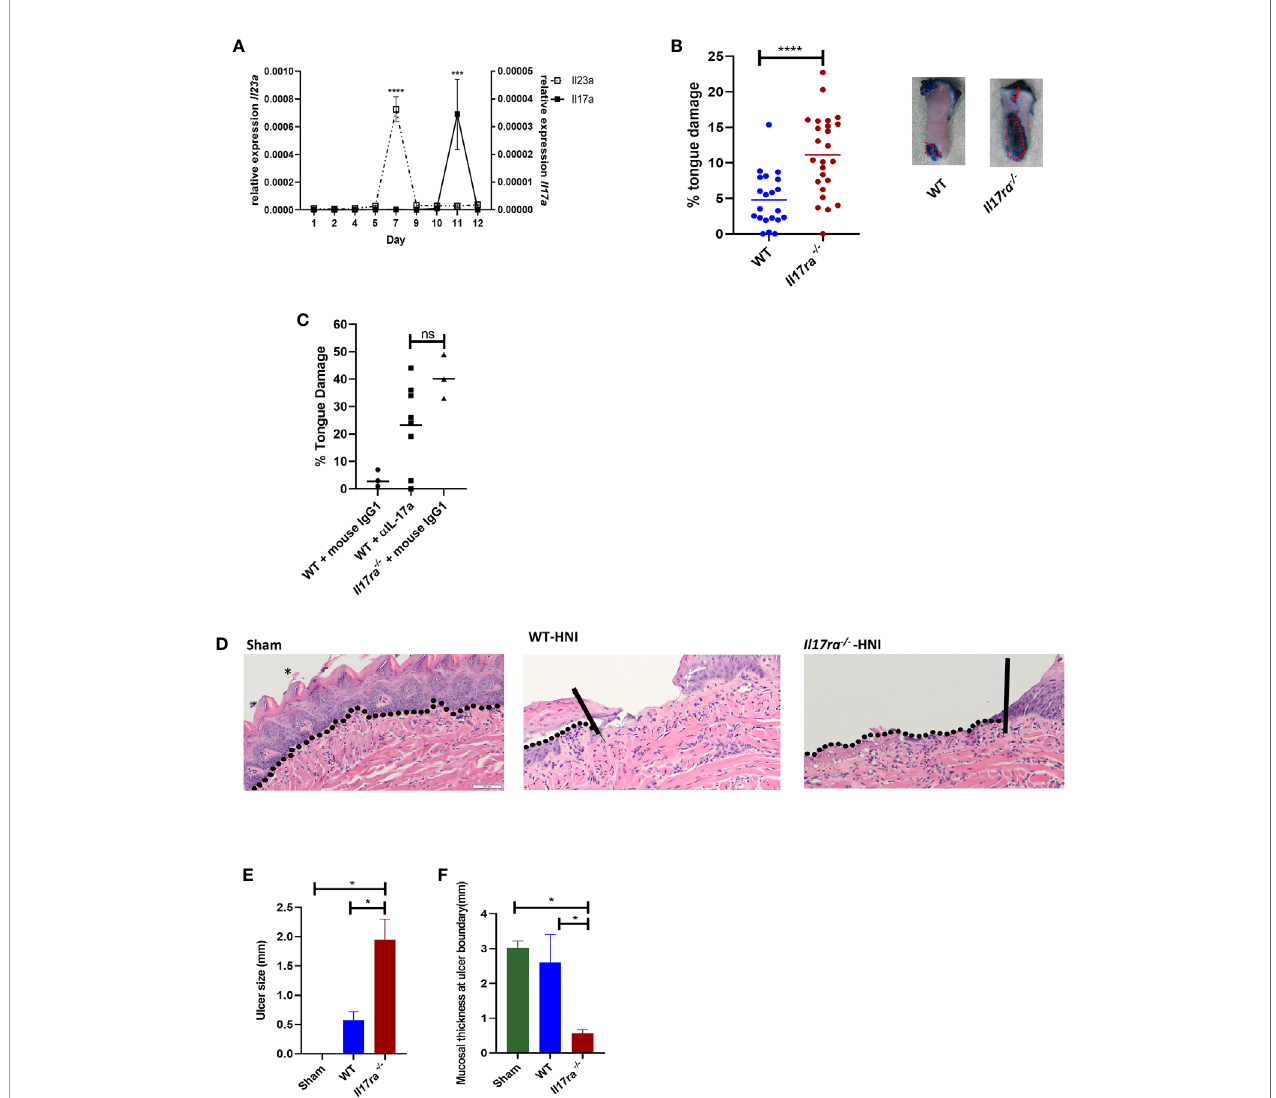
FIGURE 2 | IL-17 is induced and is protective following HNI (A) Expression kinetics of Il23 and Il17a following HNI assessed by qPCR. Results pooled from at least three experiments analyzed by ANOVA with Tukey ’ s post hoc . (B) Quanti fi cation of toluidine blue staining by determining the surface area of the tongue positive for blue staining compared to the total surface area of tongue on each mouse on day 11 post radiation. The staining on the ventral side of the tongue was not included in the quanti fi cation since this included the excision site. Red dotted lines represent the surface area of a lesion as determined for all tongues. Data pooled from at least three experiments. Analyzed by Student ’ s t test. (C) Mice were treated on days 8 and 10 with a -IL-17A or mouse IgG1 (150 µg) and damage quanti fi ed on day 11 (n = at least three per group). Control animals received appropriate isotype controls ( Supplementary Table 2 ). Tongue damage analyzed by ANOVA with Tukey ’ s. (D) Hematoxylin – eosin staining of mouse tongues D11 following radiation. Asterisk denotes papillae. The vertical lines in the images of tongues highlight the ulcer boundary and the dotted lines represent the epithelial-stromal boundary. (E, F) Quanti fi cation of lingual ulcer size and mucosal thickness (N= at least 5 per group). Data represents as least three pooled experiments. Analyzed by ANOVA with Tukey ’ s post hoc . Scale bars: 50 µM. Data shown as means ± SEM, (*P < 0.05, ***P < 0.001, ****P < 0.0001. NS is not signi fi